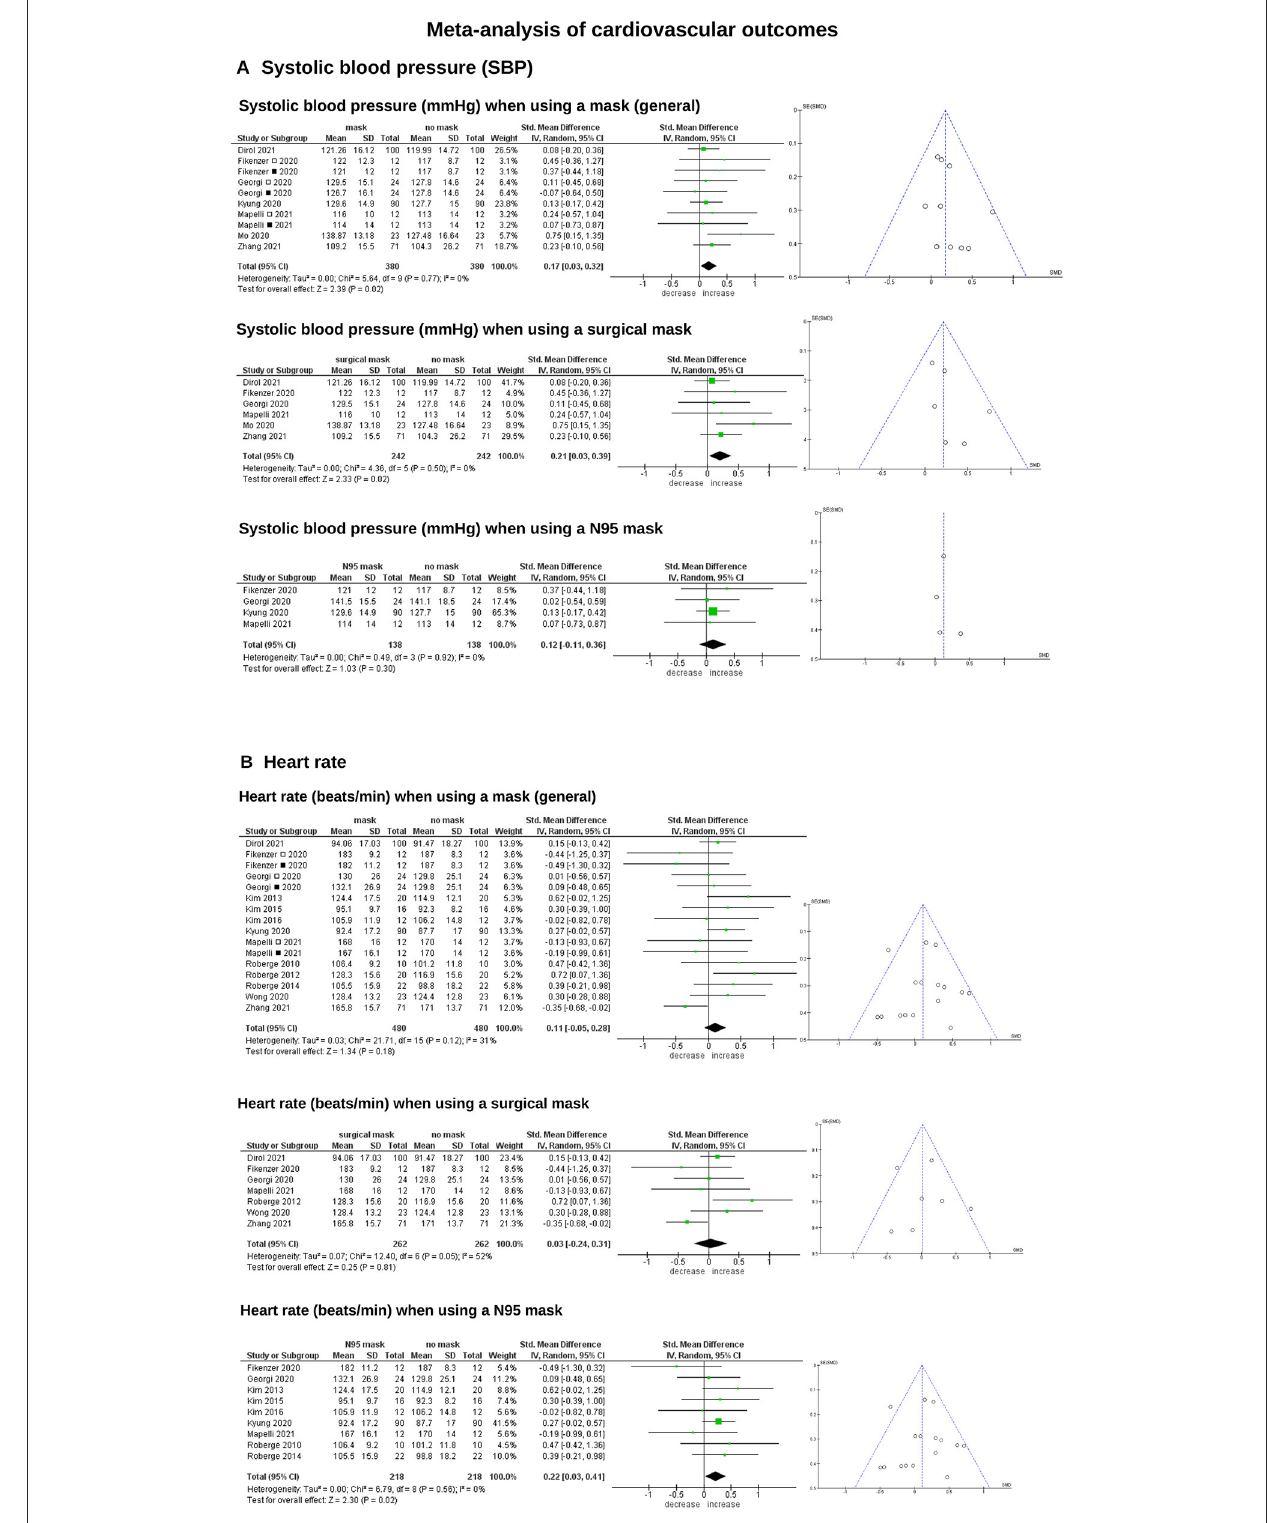
FIGURE4 Forest (left) and funnel plots (right) of meta-analysis of the physiological cardiovascular outcomes systolic blood pressure (SBP) and heart rate (HR). All controlled intervention studies in which measurements were taken during physical activity with face masks were included (exclusion of rest situation and pre-post studies). All face masks types are initially considered together, later if possible subgroups (surgical and N95) are evaluated. If studies evaluate two different mask types in parallel, the corresponding studies are marked: (cid:3) pressure is elevated in the mask condition and also for the subgroup of surgical mask. In studies evaluating both conditions (surgical and N95 mask) the N95 mask yielded always higher SBP than the surgical mask, however this effect was not statistically significant. (B) For the N95 mask condition a low significance for a slight increase in heart rate could be found. In studies evaluating both conditions (surgical and N95 mask) the N95 mask yielded always higher HR than the surgical mask, and this effect was statistically